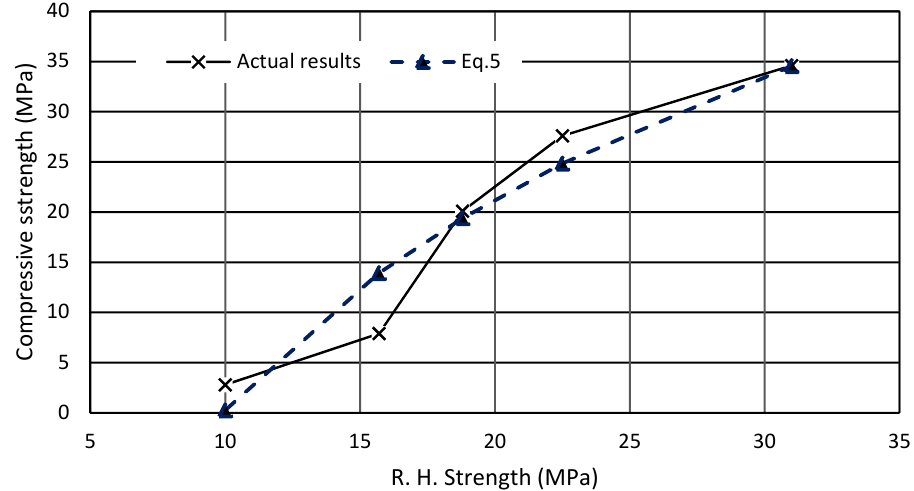
Figure 13. Actual compressive and predicted compressive based on Equation (5).